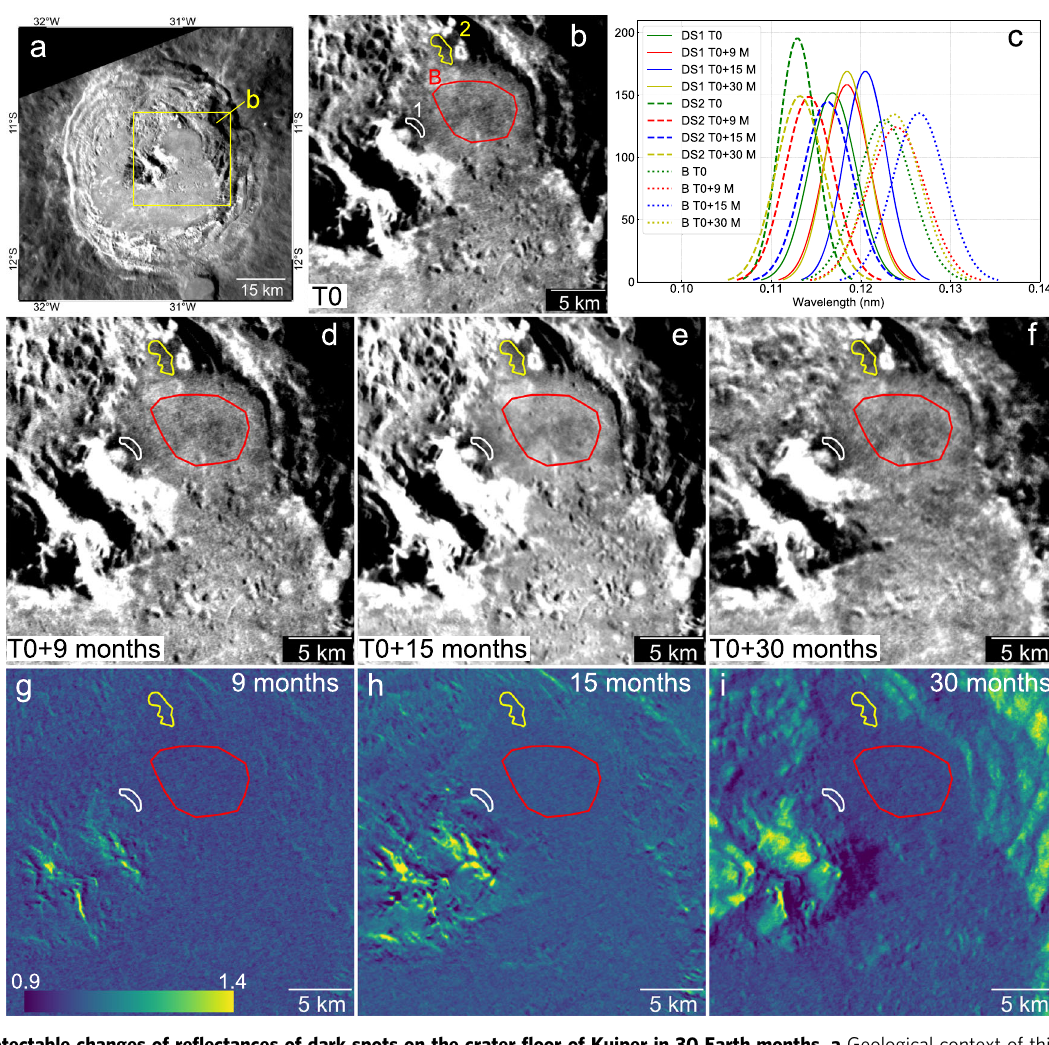
Fig. 4 No detectable changes of re fl ectances of dark spots on the crater fl oor of Kuiper in 30 Earth months. a Geological context of this observation. b Two dark spots (labeled as 1 and 2) developed along the border between the crater fl oor and central peak (white polygon), and crater fl oor and crater wall (yellow polygon). A fl at and featureless crater fl oor (red polygon) was selected for comparison. c Statistics for re fl ectances at the 750 nm wavelength at different times of the three polygonal regions. d – f Co-registered images obtained 9, 15, and 30 Earth months after the acquisition of the data shown in panel b . g – i Re fl ectance ratios obtained by dividing the after images d , e , f by the before image b . All images are in the same stretch from 0.9 to 1.4. The control networks for this region are shown in Supplementary Fig. 6. Base images used in all the panels a – f are listed in the Supplementary Table 2 and provided by NASA.